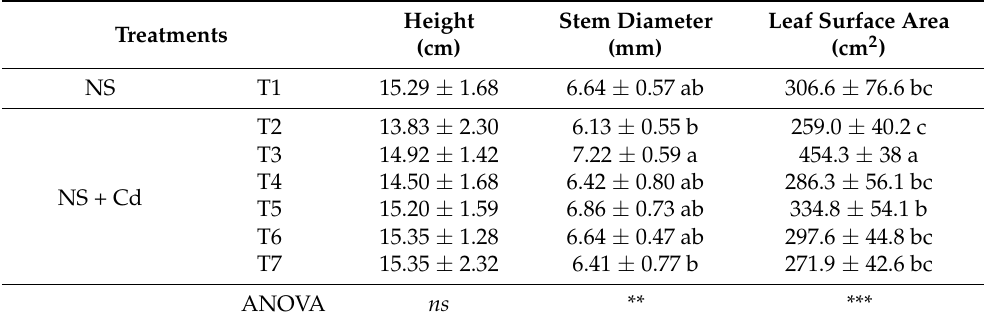
Table 1. Height, stem diameter, and leaf surface measured at the end of the experiment of the broccoli plants grown under Cd toxicity conditions and treated with different active materials to